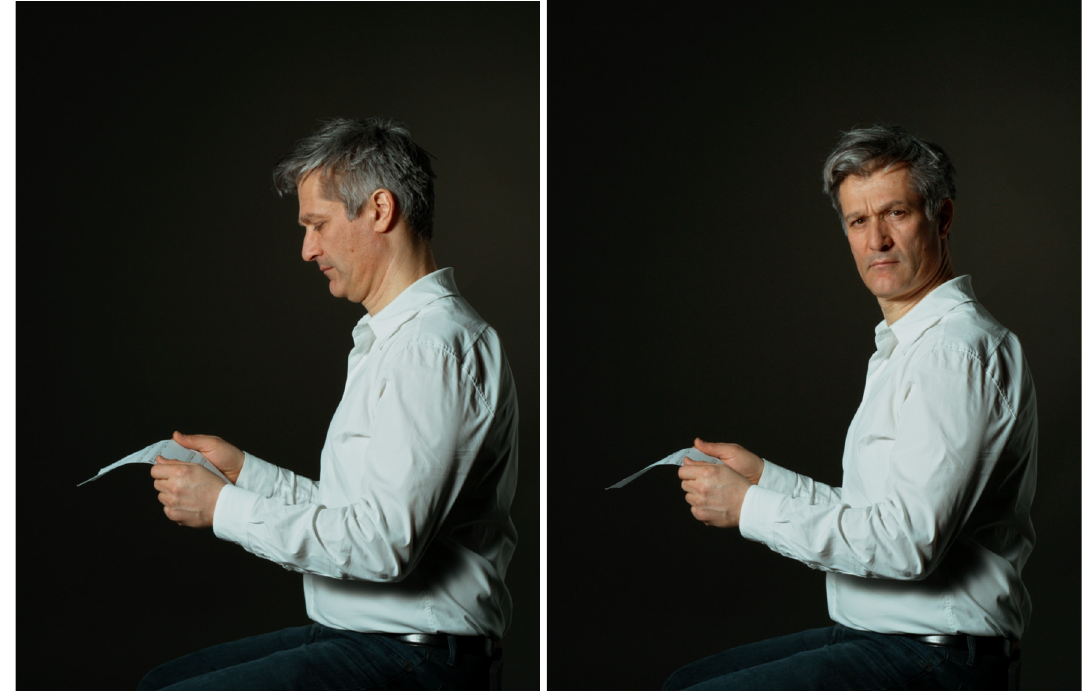
Figs. 10, 11 Jeannette Christensen, Woman Interrupted (Hans), video stills 2018